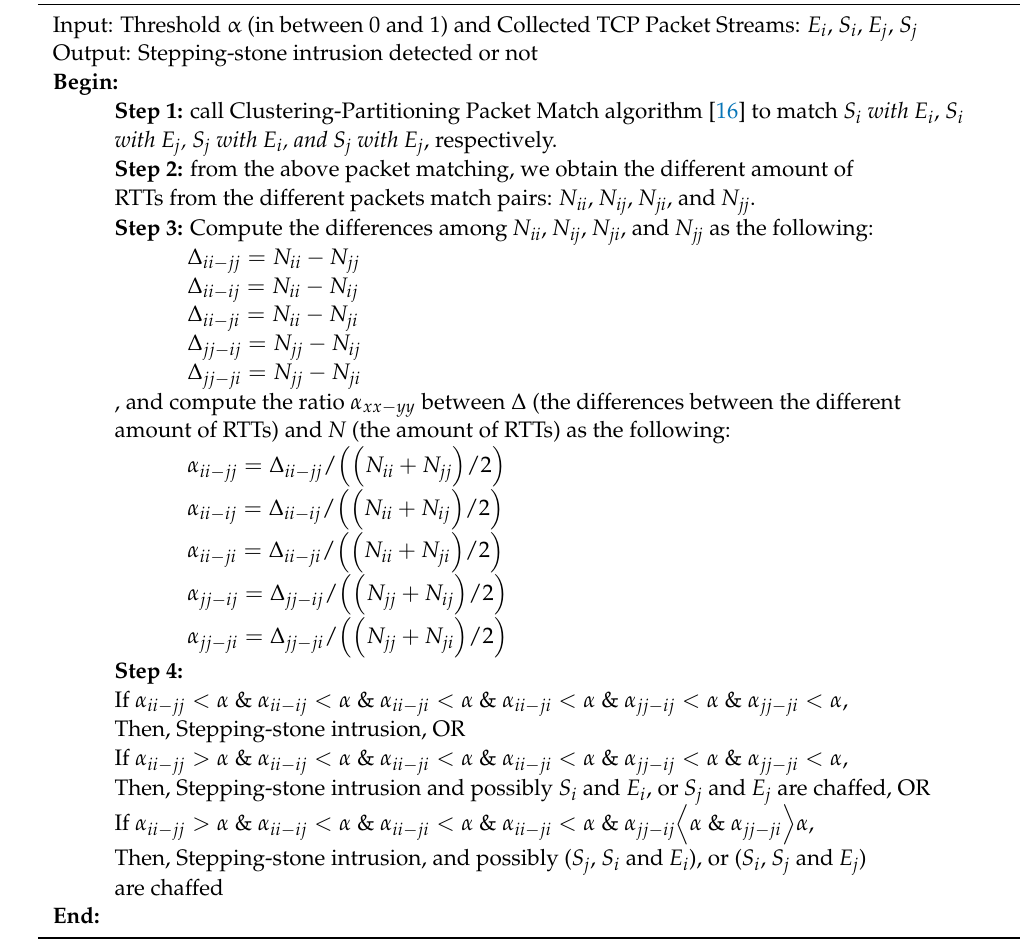
Algorithm 1: CMRW Algorithm—Cross-matching RTT-based random walk detection